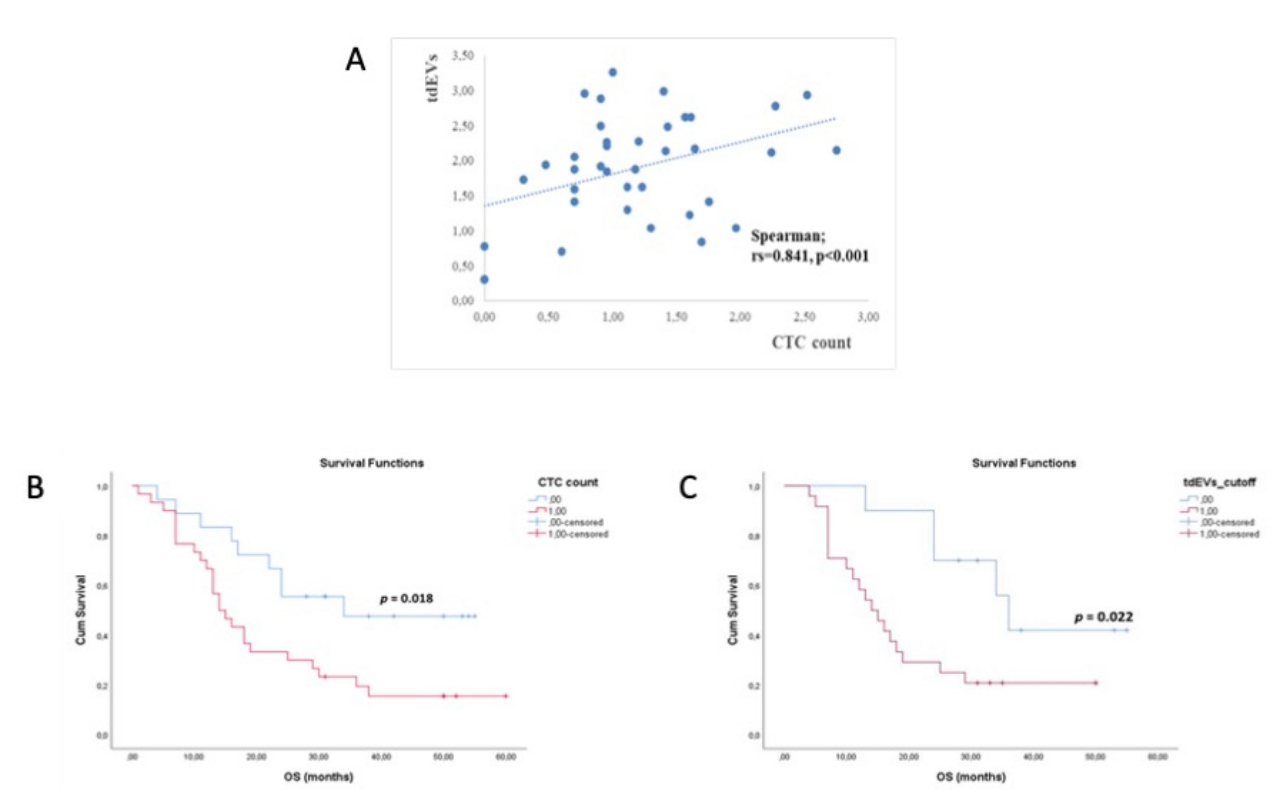
Figure 5. (A ) Spearman correlation between CTC counts and tumor-derived extracellular vesicle (tdEV) numbers, ( B ) Kaplan–Meier estimates of OS for CTC count, ( C ) Kaplan–Meier estimates of OS for tdEVs (cutoff value 20 tdEVs/7.5 mL PB.